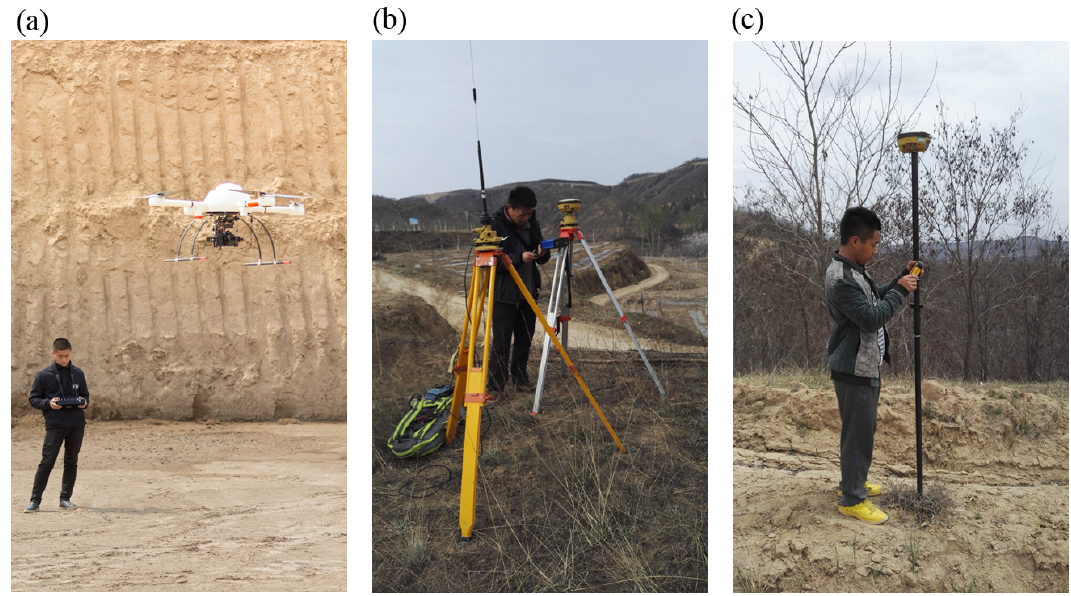
Figure 3. Illustration of the unmanned aerial vehicle (UAV) and outdoor survey: ( a ) microdrone md4-1000; ( b ) base control points surveying; and ( c ) the rover used to measure photo control points.